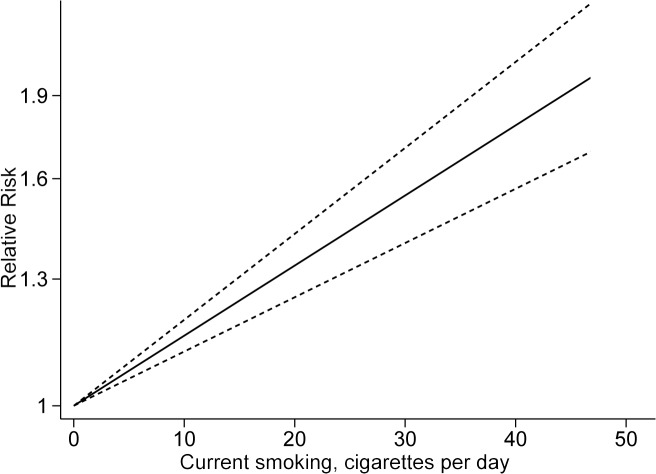
The linear dose–response relationship plot between current smoking and all-cause dementia.The solid line represents the linear trend and lines with short dashes represent its’ 95% confidence interval.